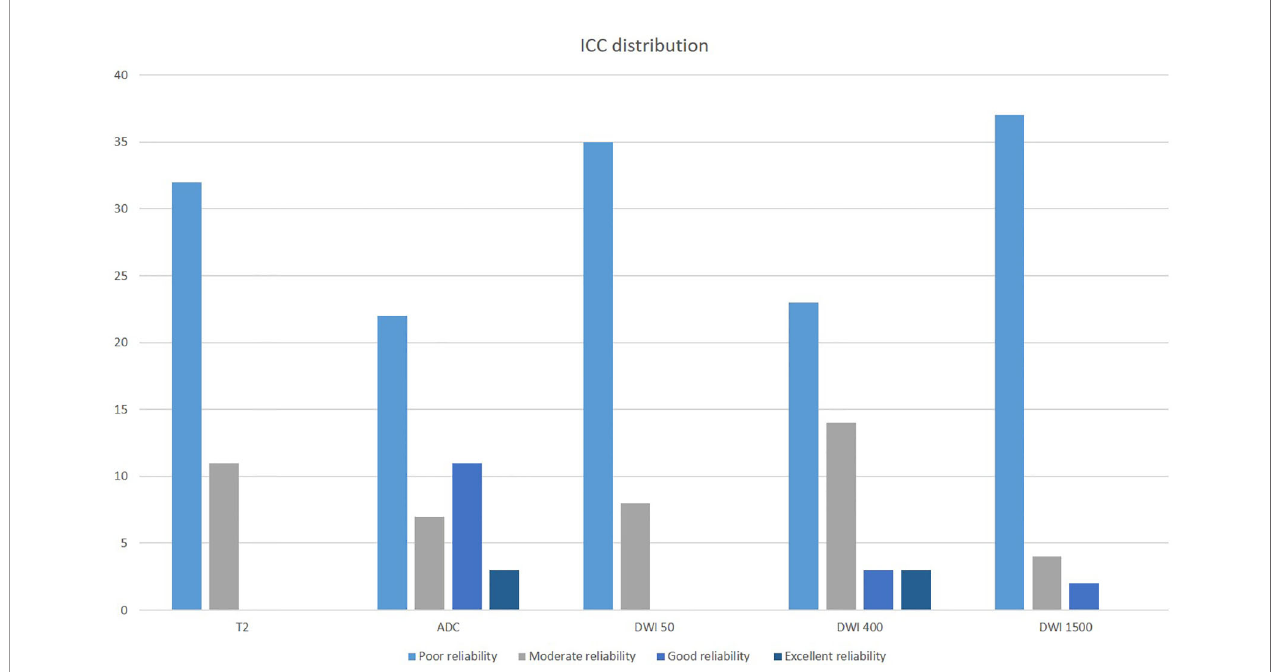
FIGURE 2 | Intraclass coef fi cient correlation (ICC) distribution of texture features across the different mpMRI imaging